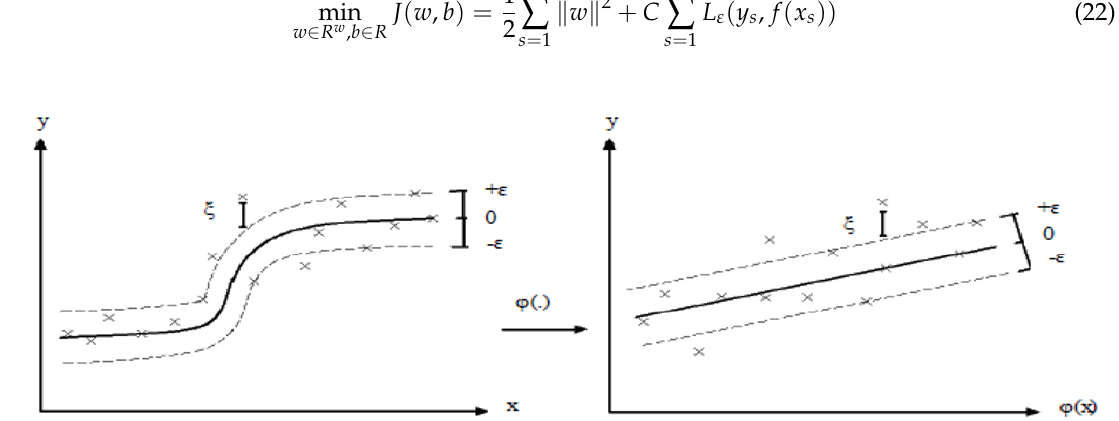
Figure 4. Using the nonlinear function ϕ (.) mapping training examples in the input space to a high dimension where they are